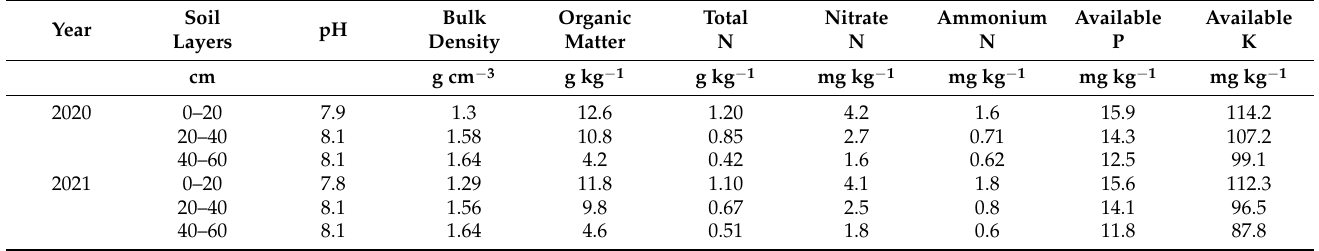
Table 3. The 0 − 60 cm topsoil characteristics of sorghum plots prior to planting in 2020 and 2021.